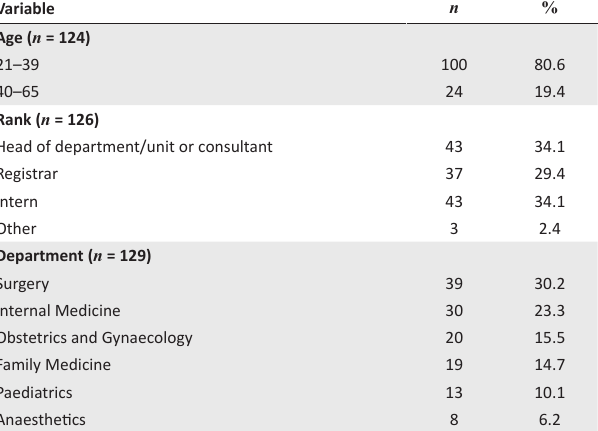
TABLE 2: Applications on smart devices and work-related usage ( n = 129). Variable n Type of medical application